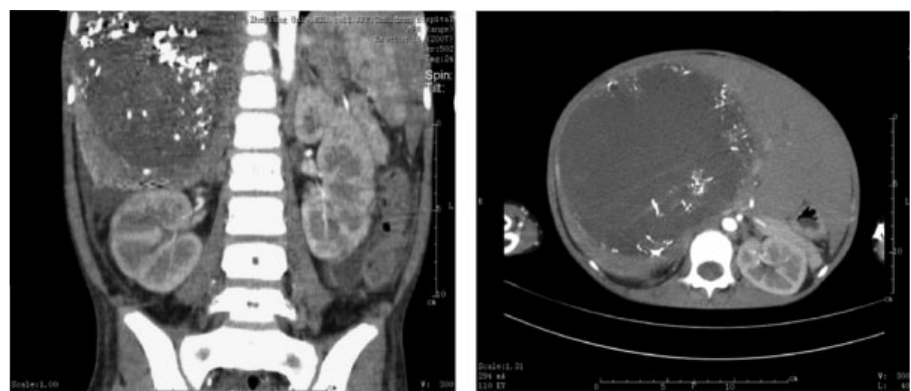
Fig. 2 The tumor shank 4 weeks after TACE of case 1. TACE, transarterial